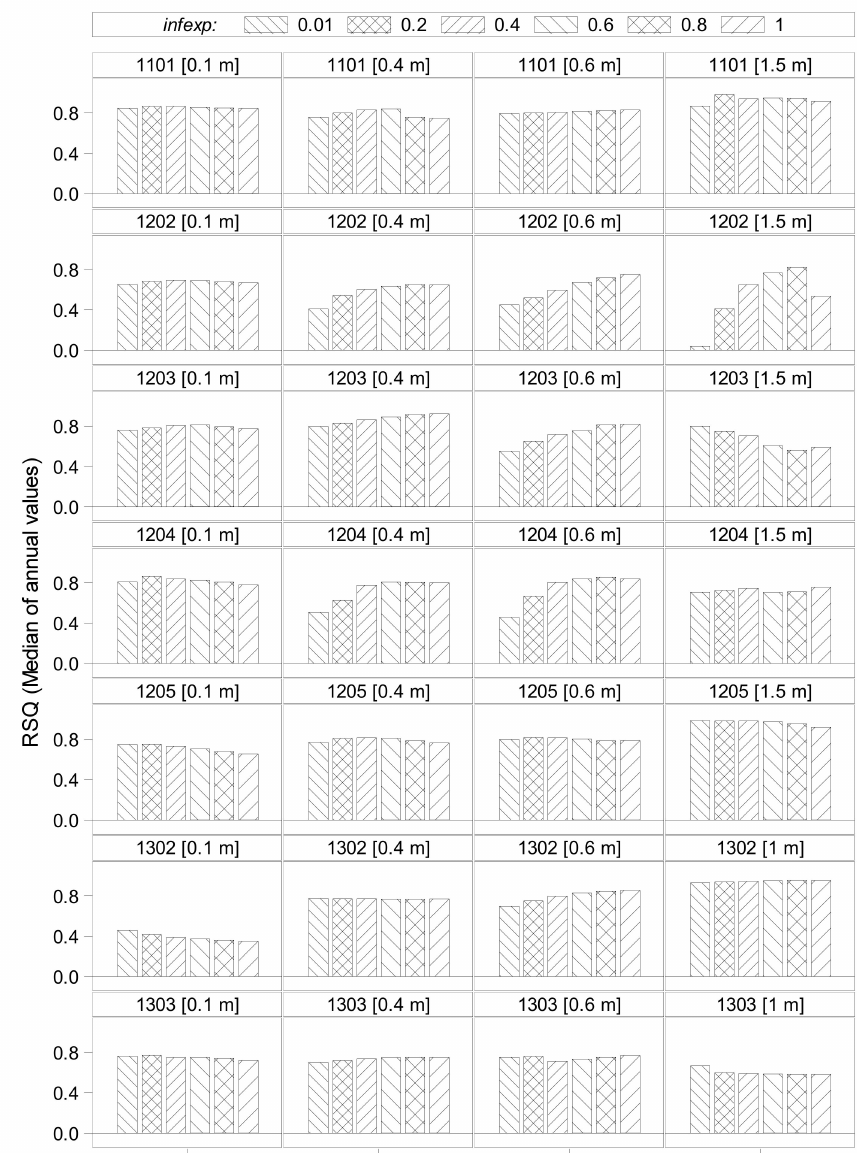
Figure 2. r 2 values of correlation of measured with modeled soil water content using varying values of the infiltration parameter infexp . Only the results for the uppermost (left column), the depths of 0.4 m and 0.6 m and lowest (right column) sensors for each site (rows) are